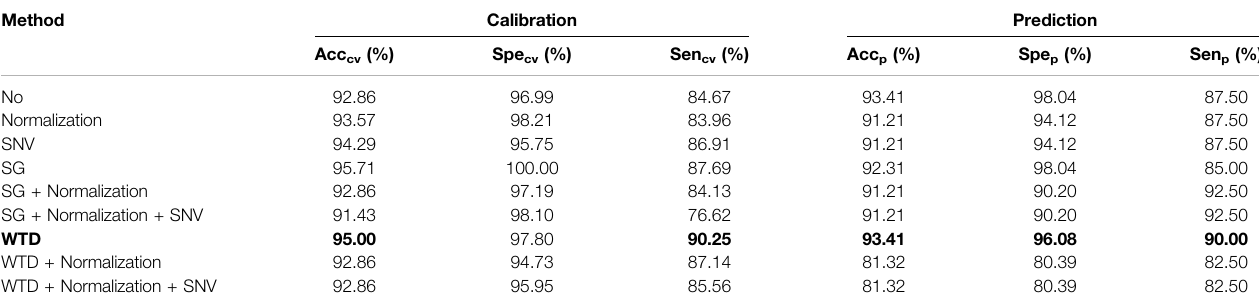
TABLE 5 | Performances of the PLS-DA model using data fusion combined with different preprocessing methods. (The best results for the PLS-DA model are presented in